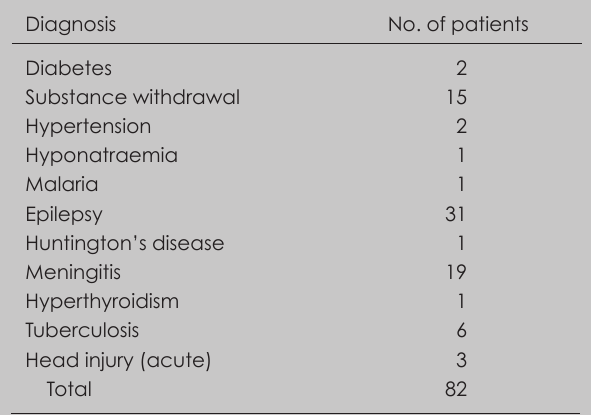
Table I . Medical causes of aggression